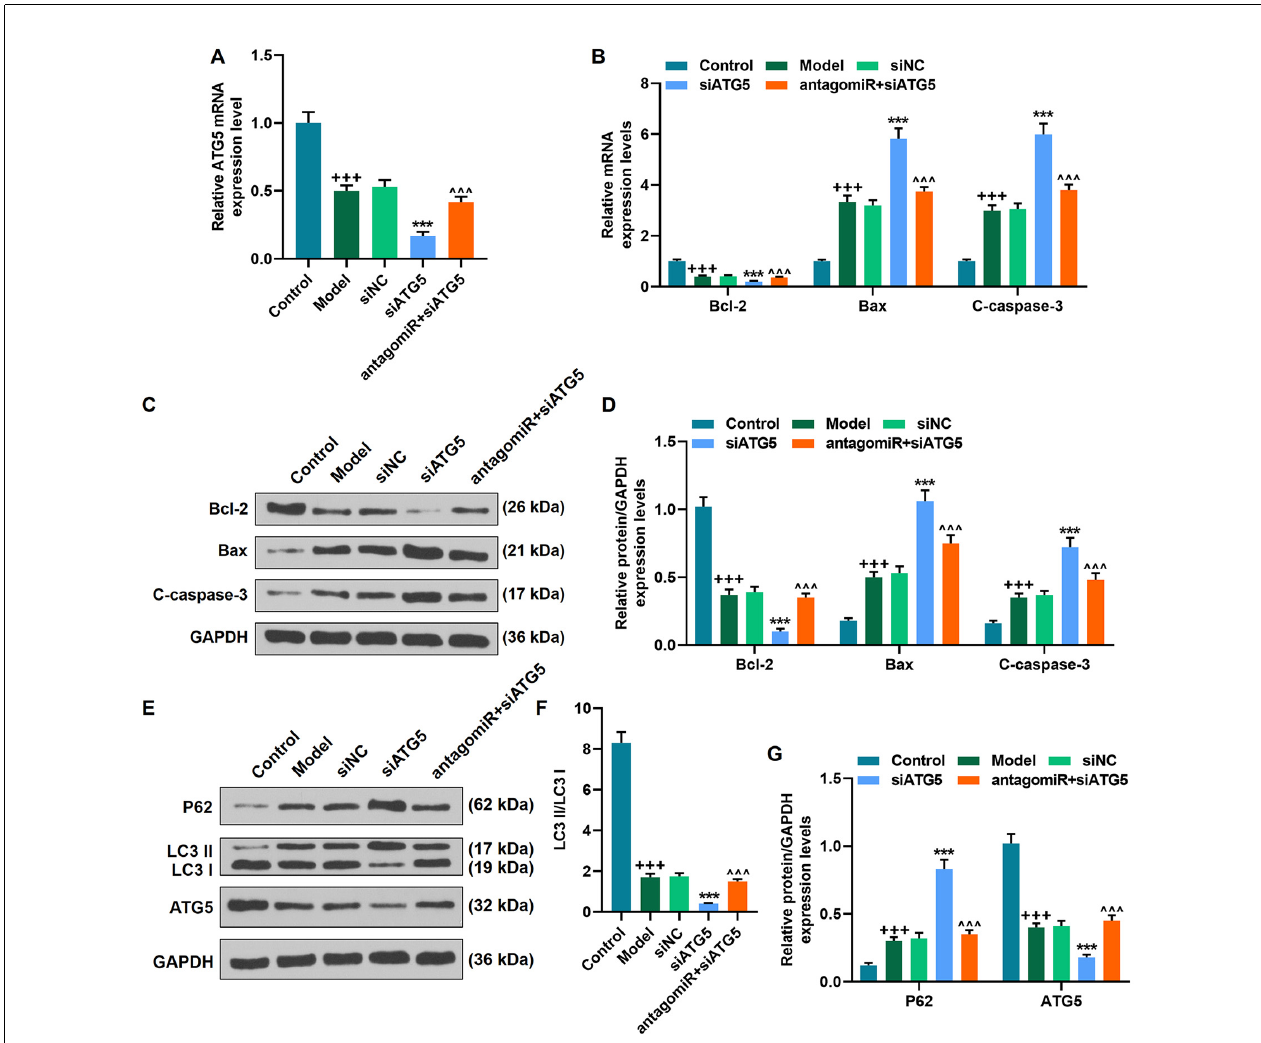
FIGURE 8 | MiR-30c-5p downregulation attenuated the progression of PD by targeting ATG5 in vivo . (A) The level of ATG5 was determined by qPCR in mice. (B–G) The level of Bax, C-caspase-3, Bcl-2, P62 LC3 II/I, and ATG5 was determined by qPCR and Western blot. +++ p < 0.001 vs. Control. *** p < 0.001 vs. siNC. ∧∧∧ p < 0.001 vs. siATG5. siNC, negative control for